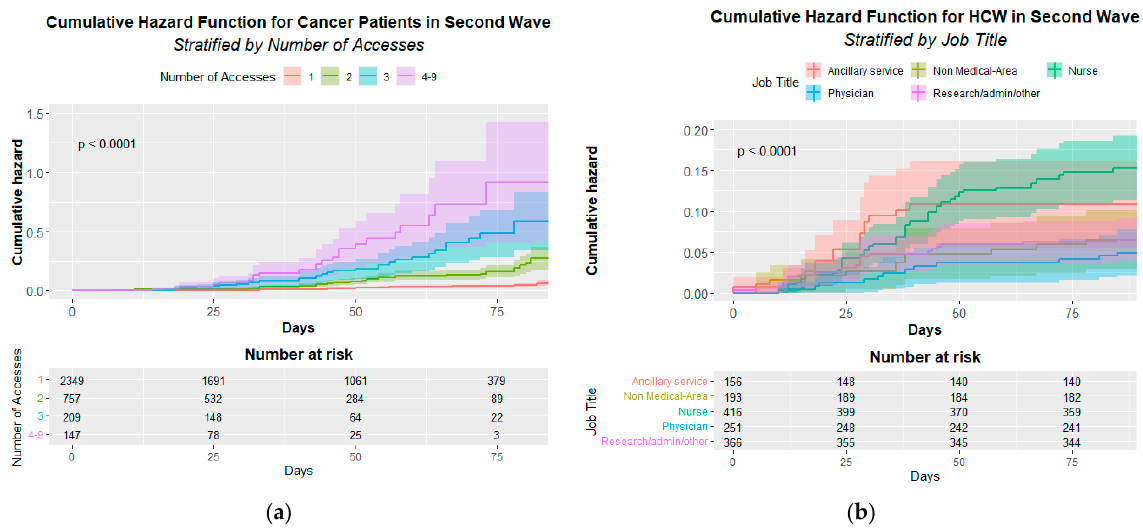
Figure 2. Cumulative Hazard Function for cancer patients ( a ) and Healthcare Workers ( b ). ( a ) Infection Cumulative Hazard Function by patient’s accesses in the second pandemic wave. The p -value of the Log-rank test is at the top left. ( b ) Infection Cumulative Hazard Function by HCWs’ job title (Healthcare Workers’ Job Title) in the second pandemic wave. The p -value of the Log-rank test is at the top left.